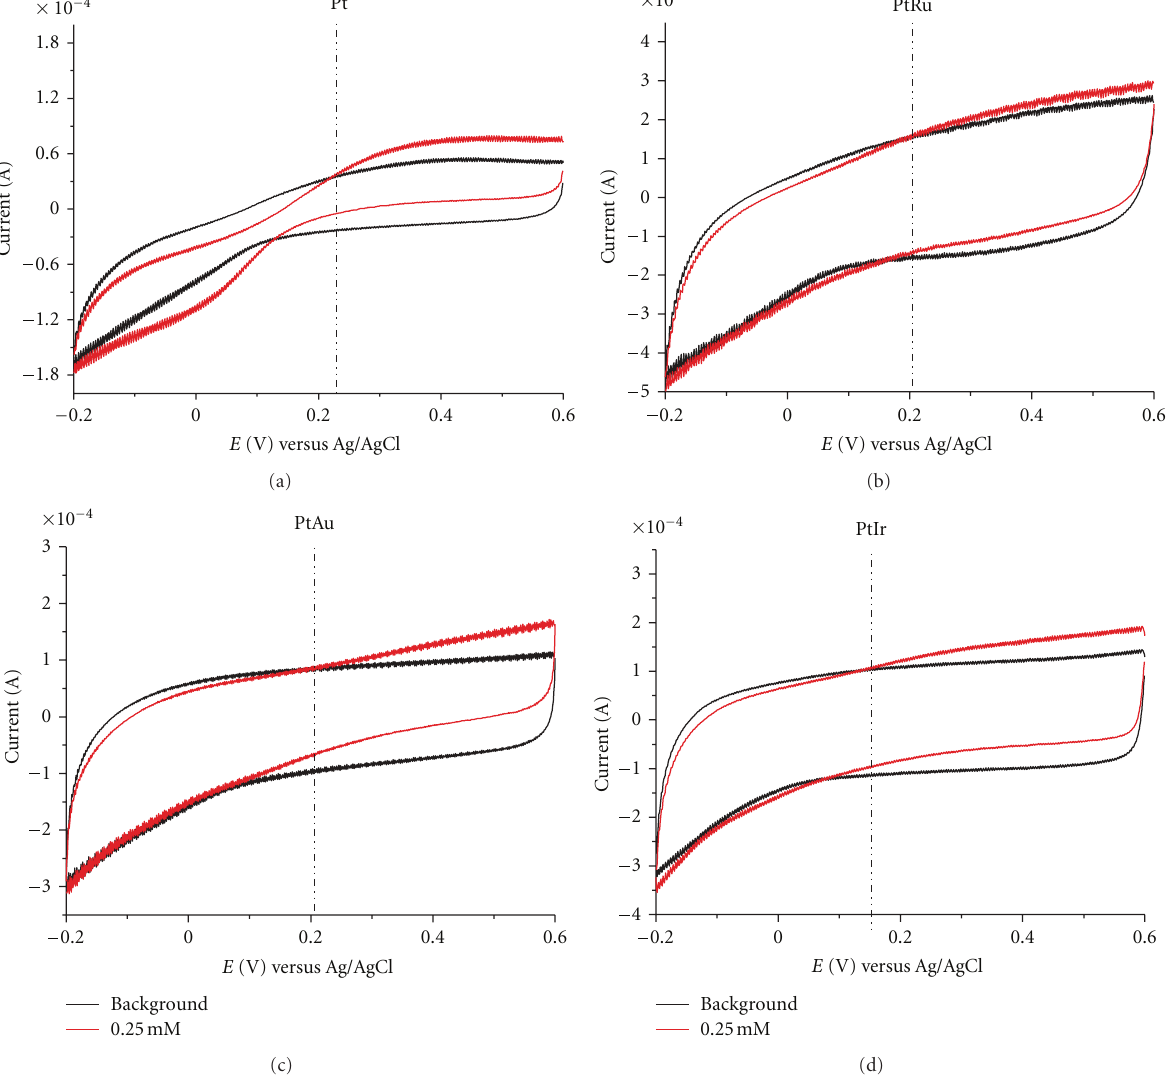
Figure 4: Cyclic voltammetric responses of di ff erent metallic catalysts at 0.25 mM H 2 O 2 in PBS (pH = 7 . 4), at 50 mV/s scan